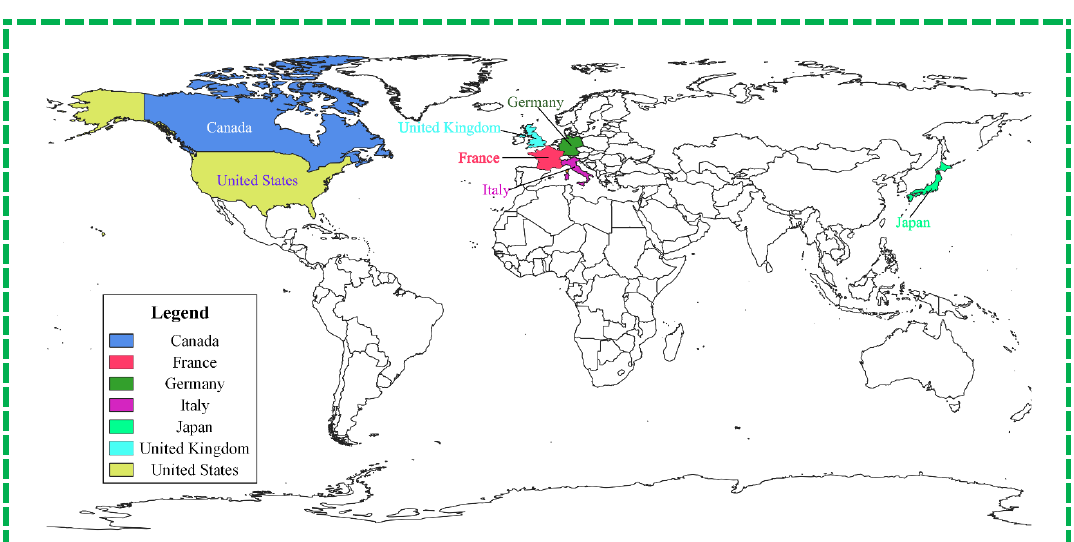
Figure 2. Geographical coverage of G-7 countries.